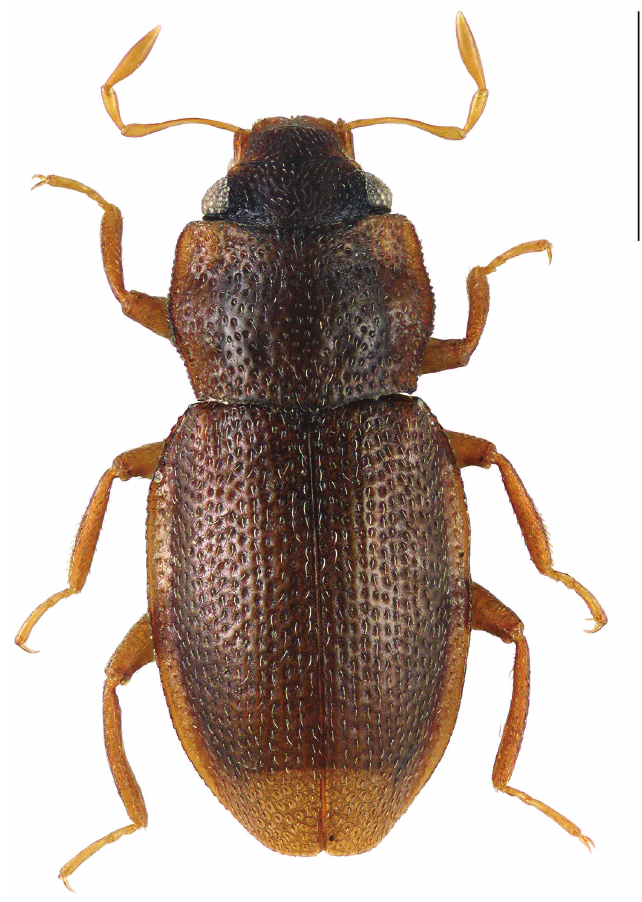
Figure 2. Habitus of Hydraena matyoti Jäch & Delgado, sp. n., holotype, male. Scale bar: 0.5 mm. Type material. Holotype ♂ (NMW), glued on pinned card, genitalia extracted and glued on same card. Label data: “SEYCHELLES: Mahé Sans Souci, XI. 1994, leg.E.Heiss”. Paratypes: 1 ♀ (NMW): same label data as holotype; 1 ♂ (NMW): “SEYCHELLES: Mahé Morne Seychellois NP Casse Dent, trail 25.03.2011 leg. M.Madl”; 2 ♀♀ (NMW): “SEYCHELLEN, Mahé 1996 Morne Seychellois NP Con- go Rouge 600-800m 25. V. leg. Schödl (12c)”; 1 ♀ (NMW): “Seychelles, Silhouette, Jardin Marron [field name], 400m, 12. 4. 2007, leg. Wewalka (12)”. Description. Habitus as in Fig. 2. Body length (without abdomen): 1.56–1.70 mm. Dorsum reddish brown, lateral parts of frons (near eyes) more or less black; max- illary palpi yellowish, apical tip paled. Labrum deeply excised anteriorly; anterior angles rounded. Middle of clypeus sparsely punctate, usually glabrous, lateral parts usually micropunctate and mat. Fronto-clypeal suture straight or feebly arcuate, slightly impressed. Frons